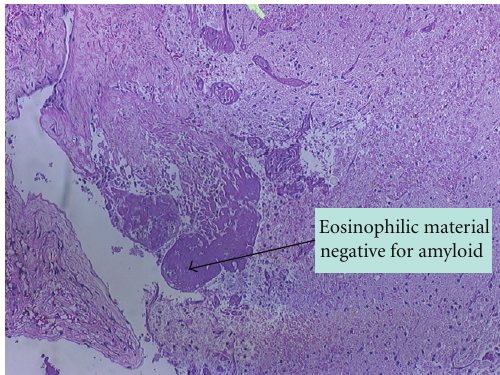
Figure 2: Brain biopsy was positive for eosinophilic material (similar to the lungs) but negative for congo red and thioflavin T